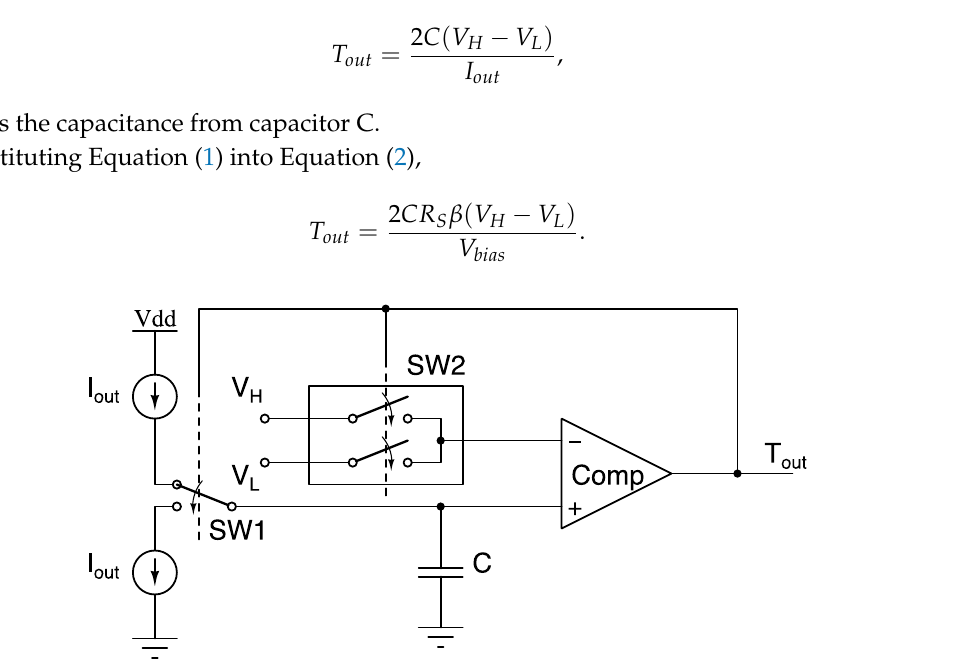
Figure 3. Implementation of the Current Controlled